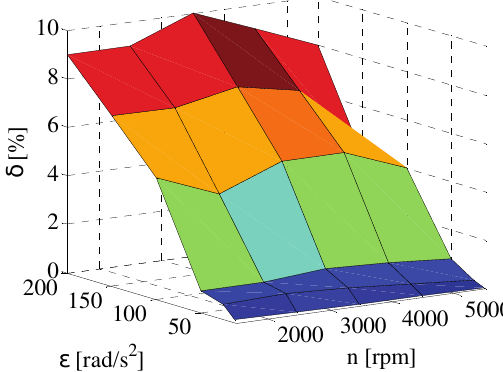
Fig. 10. Error δ in function of engine speed n and angular acceleration ε for throttle opening 30º When angular acceleration is about 50 rad/s 2 the difference becomes